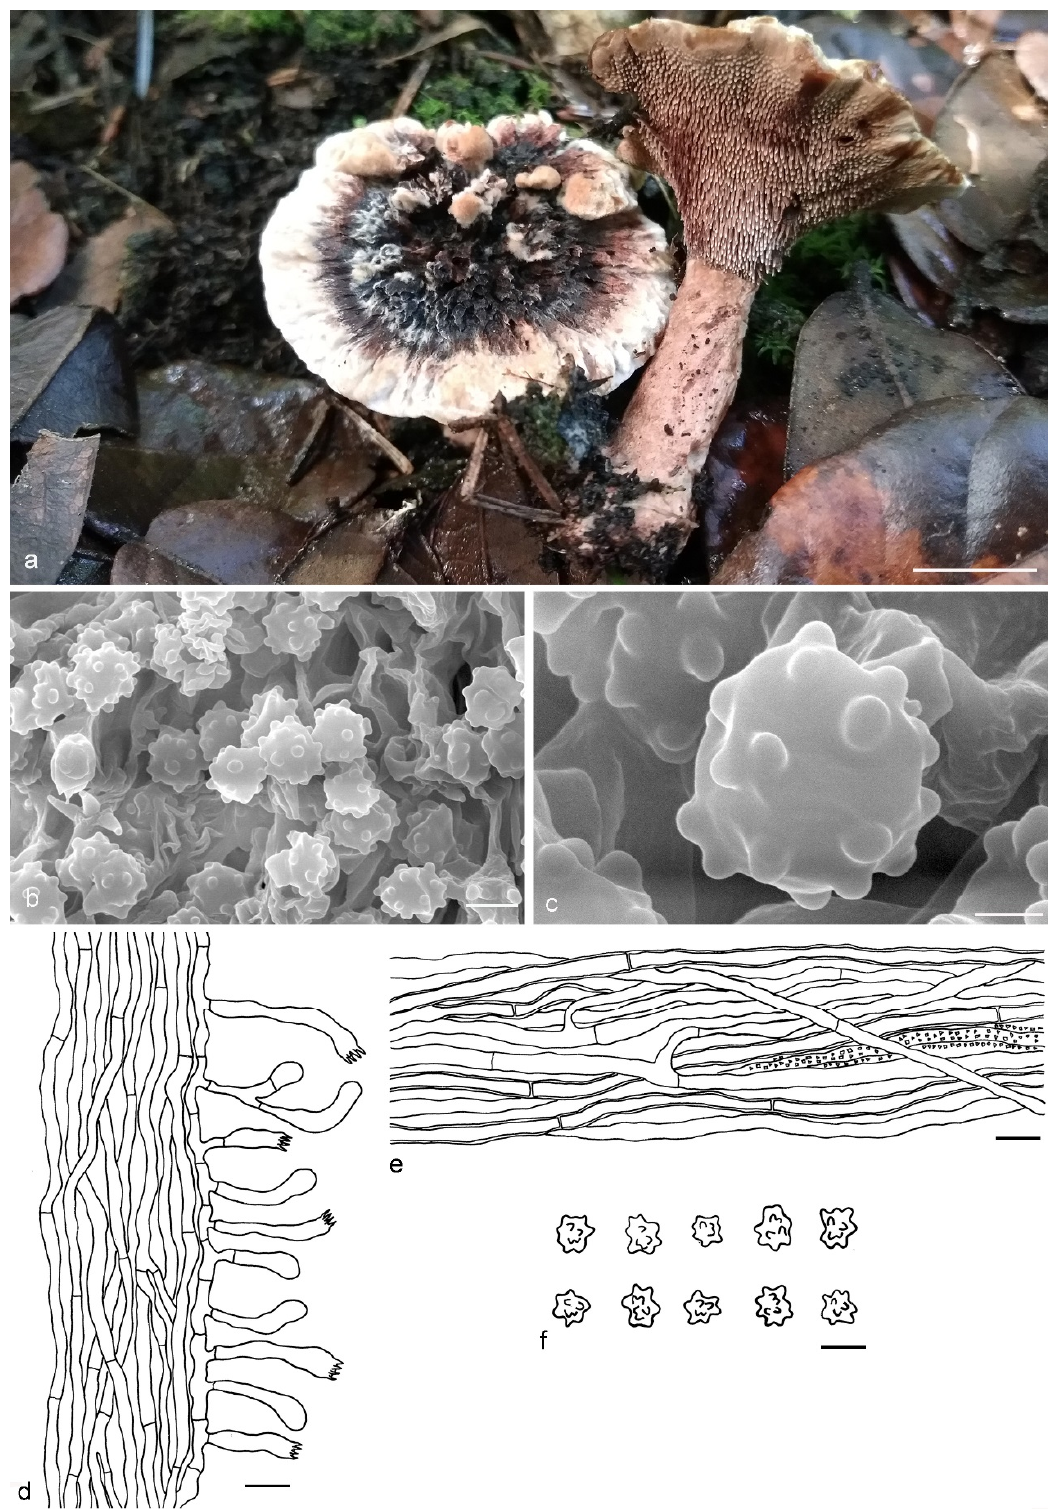
Figure 11. Hydnellum squamulosum. ( a ): Basidiocarps; ( b , c ): SEM of basidiospores; ( d – f ): Microscopic structures (drawn from IFP 019418); ( d ): Section of hymenophore trama with basidia; ( e ): Hyphae from pileus context; ( f ): Basidiospores. Scale bars: ( a ) = 1 cm; ( b ) = 3 μm; ( c ) = 1 μm; ( d , e ) = 10 μm; ( f ) = 5 μm. Hydnellum sulcatum Y.H. Mu & H.S. Yuan, sp. nov. (Figure 12) MycoBank MB839043; Etymology . Sulcatum (Latin), refers to the often grooved pileal surface.